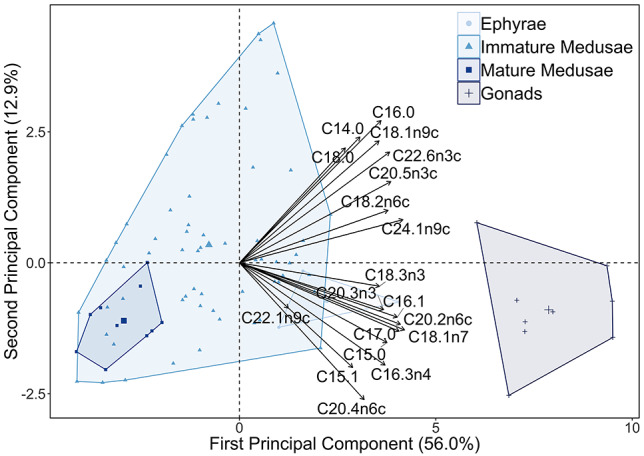
Principal component analysis for FA profiles of A. aurita (n = 84). Profiles are grouped according to tissue type of the life stages. The ephyrae (circles), immature (triangles) and mature medusa (squares) represent bell and oral arm tissues, while the gonads (plus sign) represent reproductive tissues separated from mature medusa. The slightly larger icons in the plot represent group means for each tissue type, while vectors indicate the various FA’s. The first principal component explains 56.0% of the variation, while the second principal component explains 12.9%.